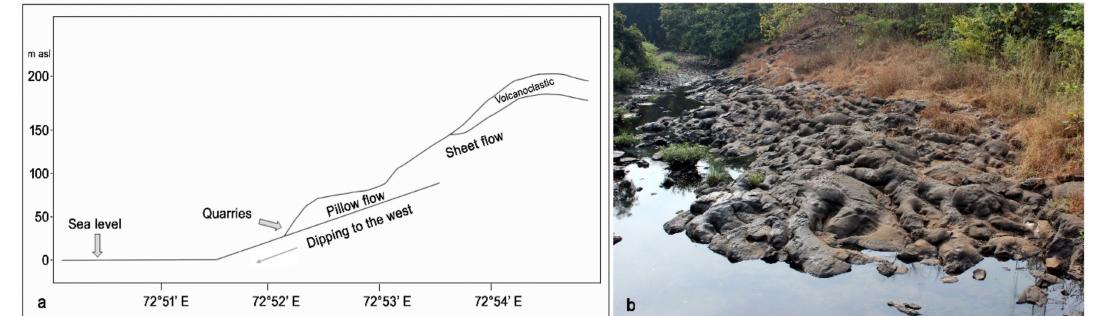
Figure 2. ( a ) Schematic illustration of an east–west section between an imaginary north–south line of the quarries and the Kanheri caves, displaying the position of the quarries and the Dahisar river bed pillow basalts. The pillow basalts and sheet lava are overlain locally by volcaniclastics. ( b ) Oblong entities of a pillow flow in the Dahisar river bed. The stream bed is ~15 m